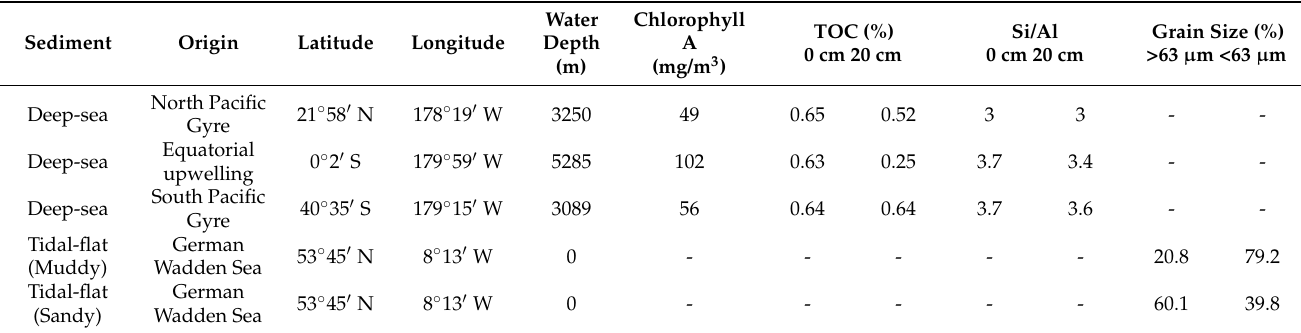
Table 1. Characteristics of the marine sediment samples used to test the protocol for enumeration of sediment viruses via flow cytometry, for deep-sea sediments from 0 cm and 20 cm depth and tidal-flat sediments.